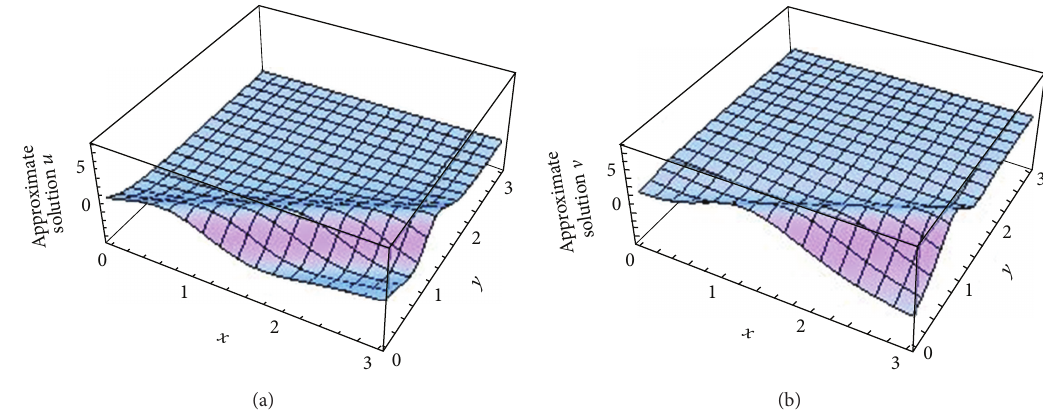
Figure 3: The surfaces show (a) the numerical approximate solution of 𝑢(𝑥,𝑦, 0.3) and (b) the numerical approximate solution of V (𝑥,𝑦, 0.3) when 𝛼 = 1/4 and 𝛽 = 1/2